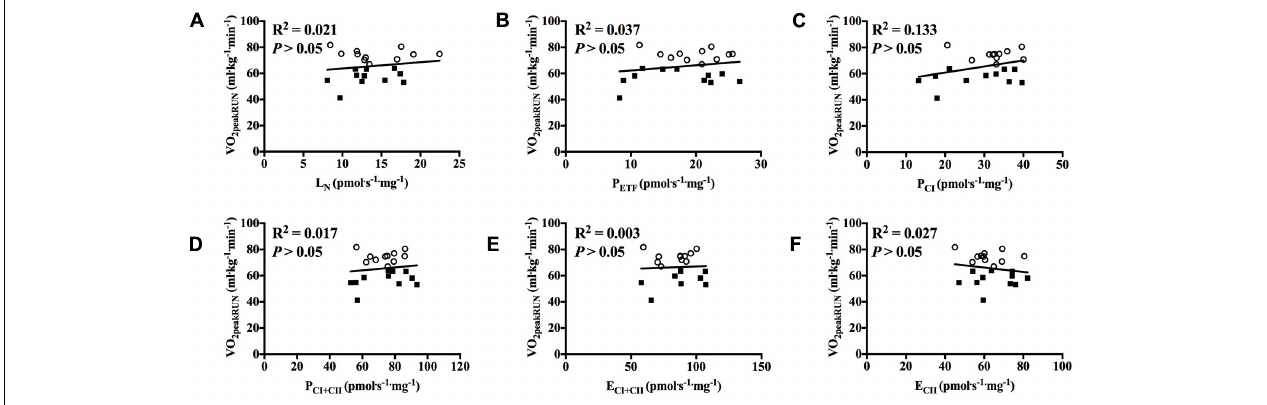
FIGURE 5 | Correlation between peak oxygen uptake (VO 2peak ) in running and respiratory flux for M. vastus lateralis with participants pooled. (A) leak respiration in absence of adenylates (L N ), (B) fatty acid oxidative capacity (P ETF ), (C) complex I respiration (P CI ), (D) complex I and complex II respiration combined (P CI + CII ),